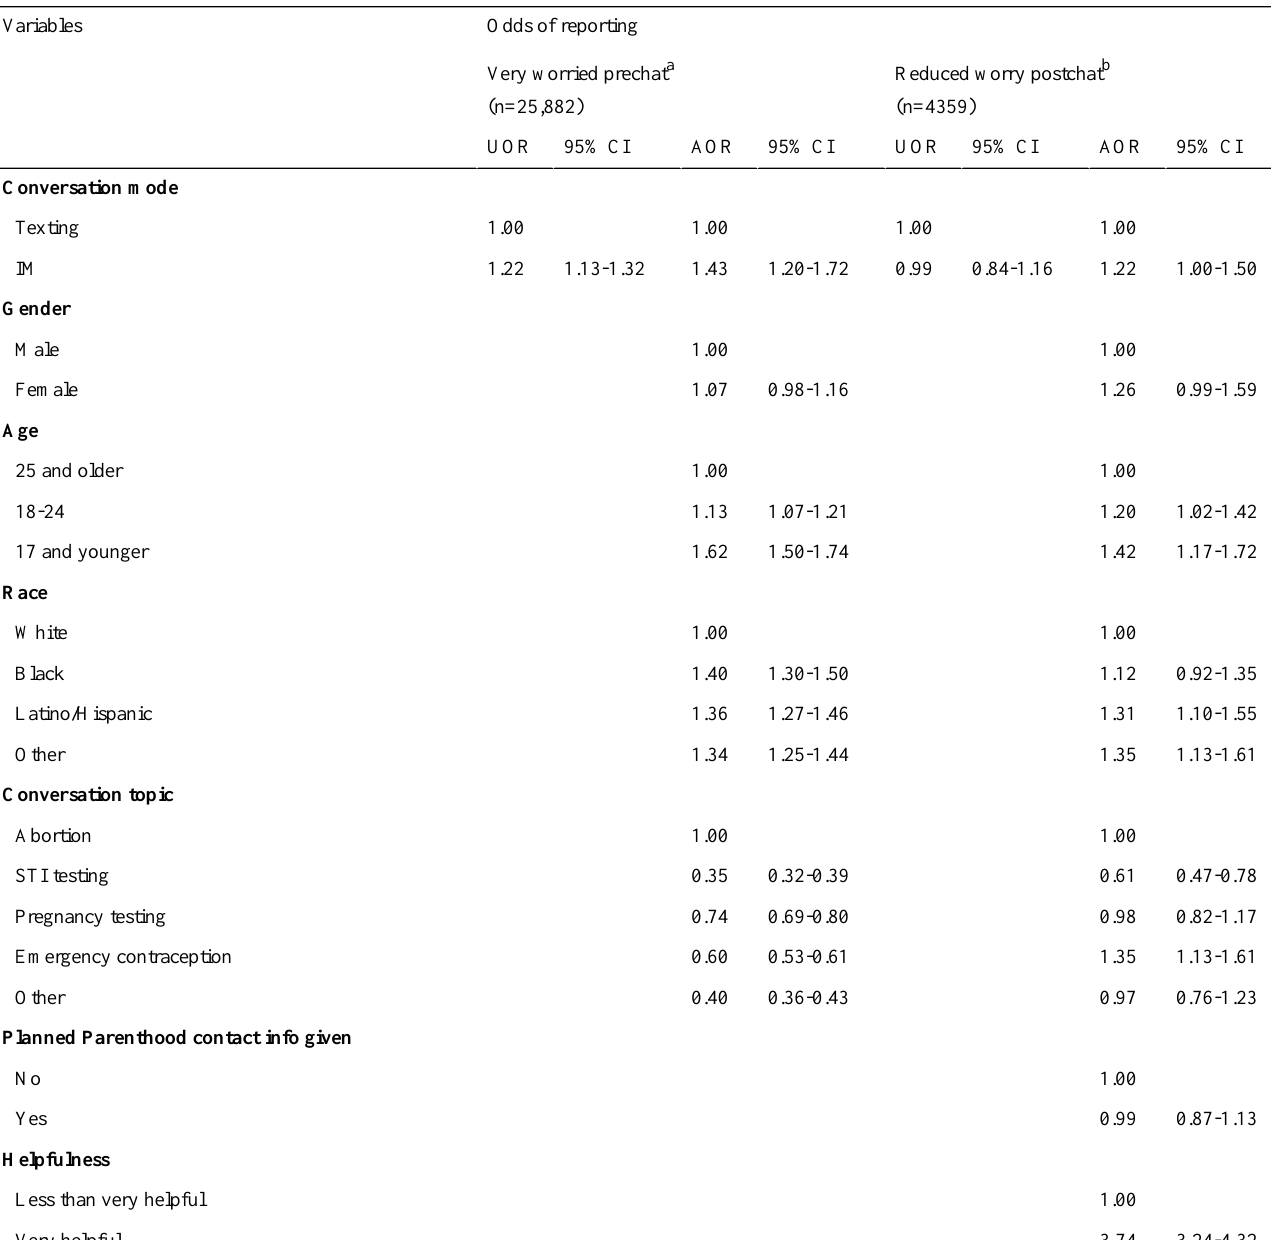
Table 4. Unadjusted (UOR) and adjusted (AOR) logistic regression estimates of the relationship between conversation mode and worry measures. Odds of